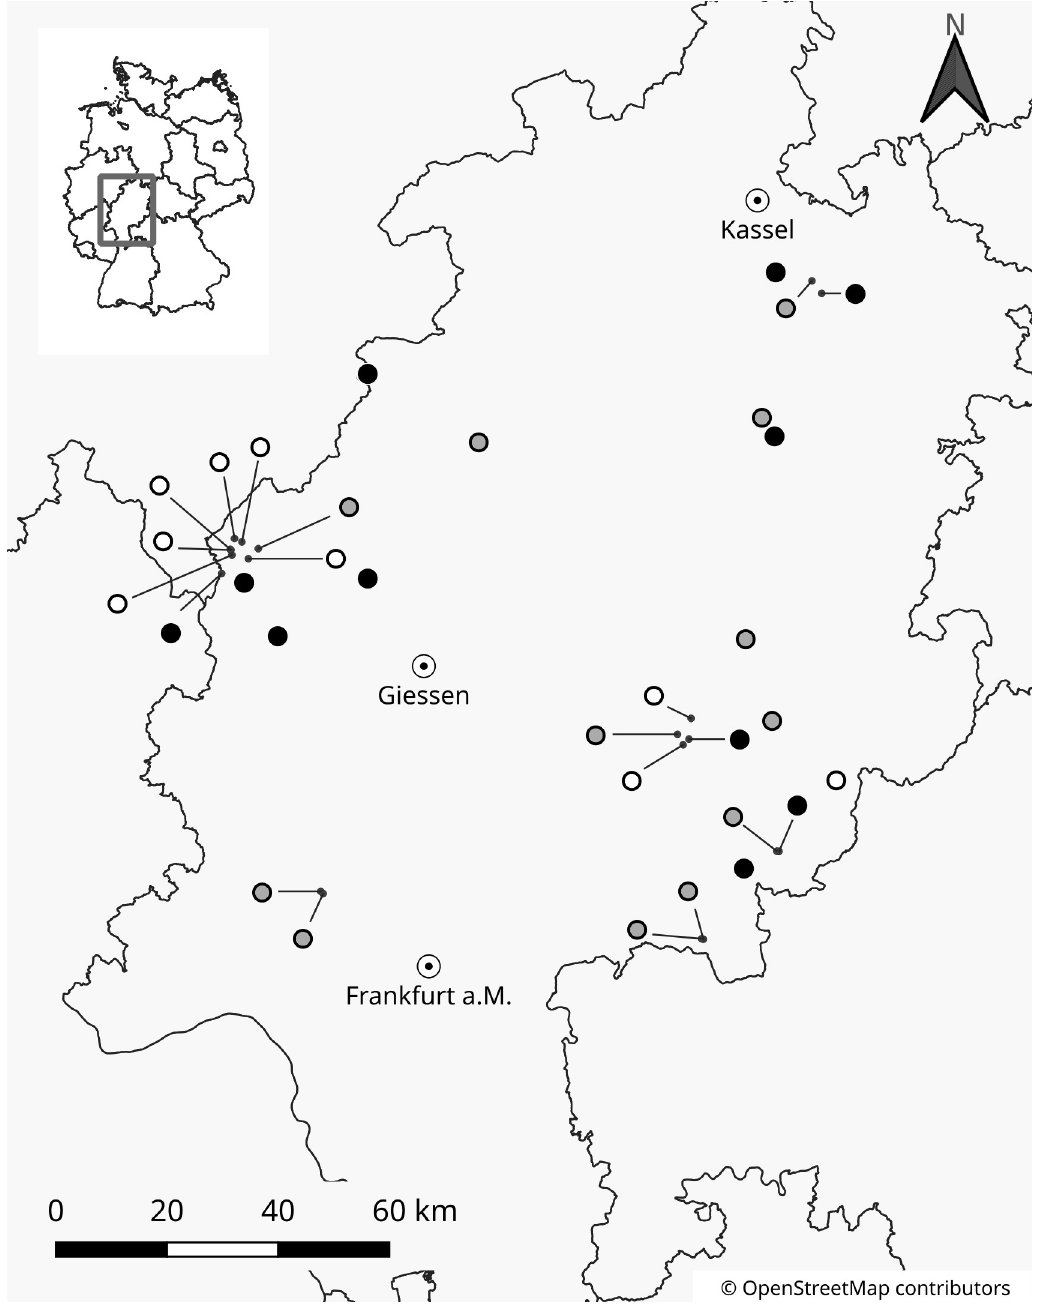
Fig 1. Location of the 32 field sites of extinct (white), small (gray) and large (black) A . montana populations. All sites were located in Hesse,